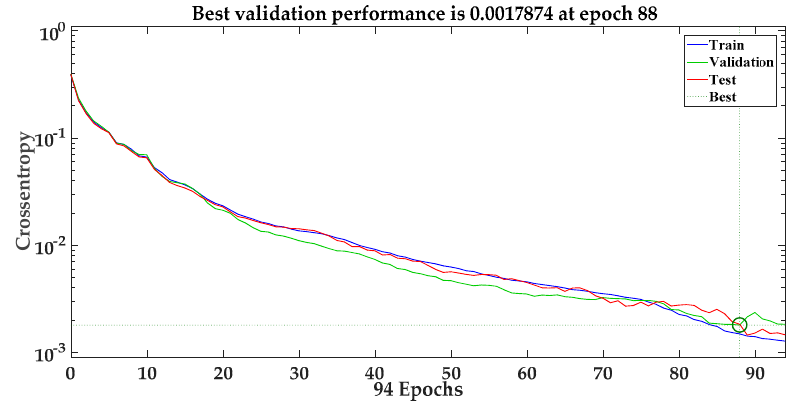
Figure 8. Training process of the BP neural network.